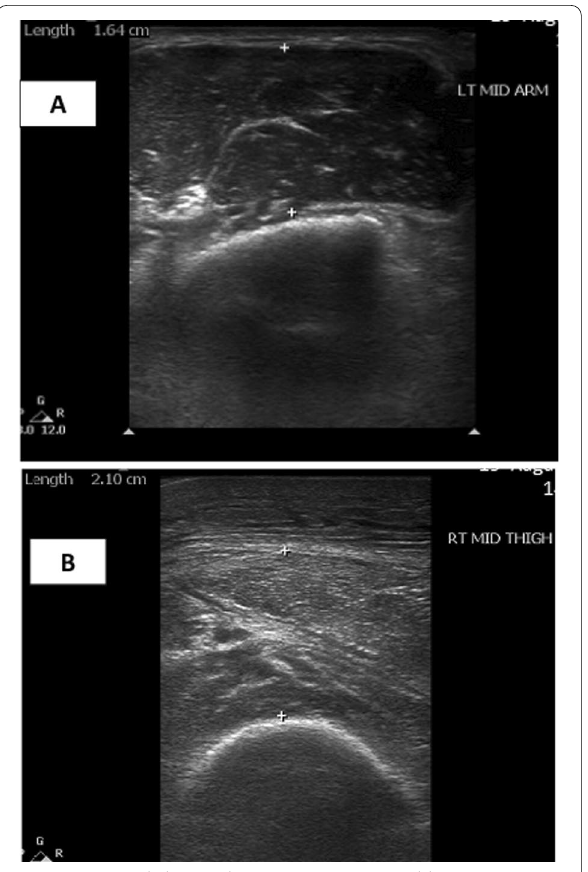
Table 1 Demographic data of the studied